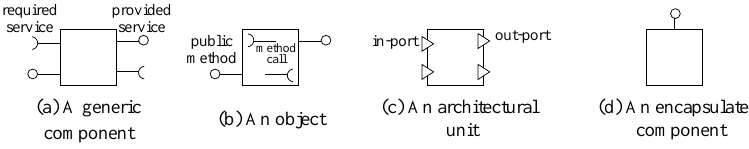
Figure 1. Components in current component